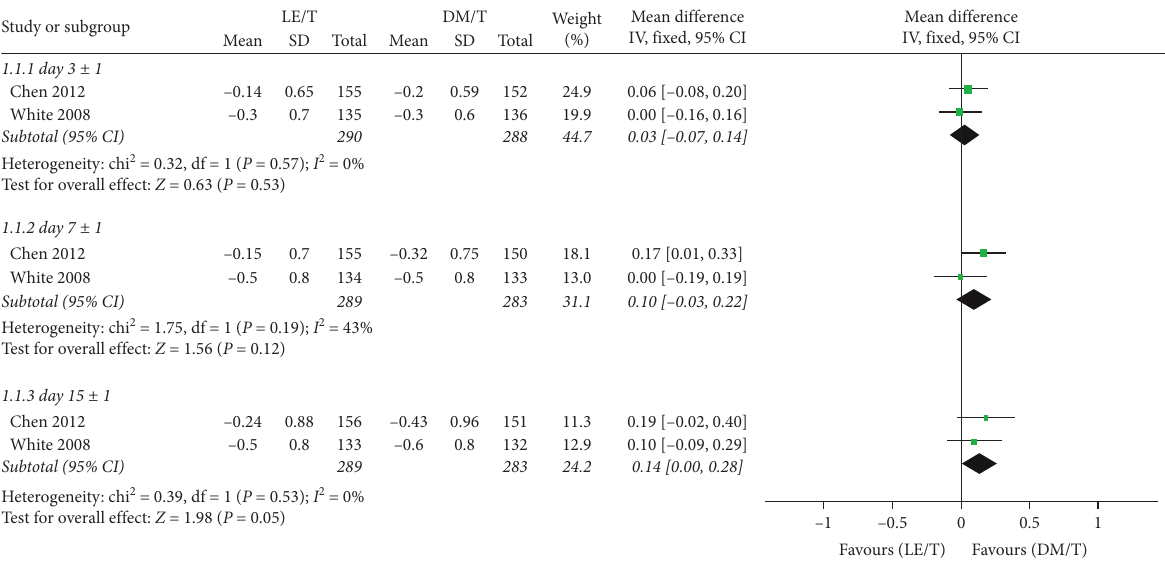
Figure 8: Forest plot of CFB in keratitis signs composite